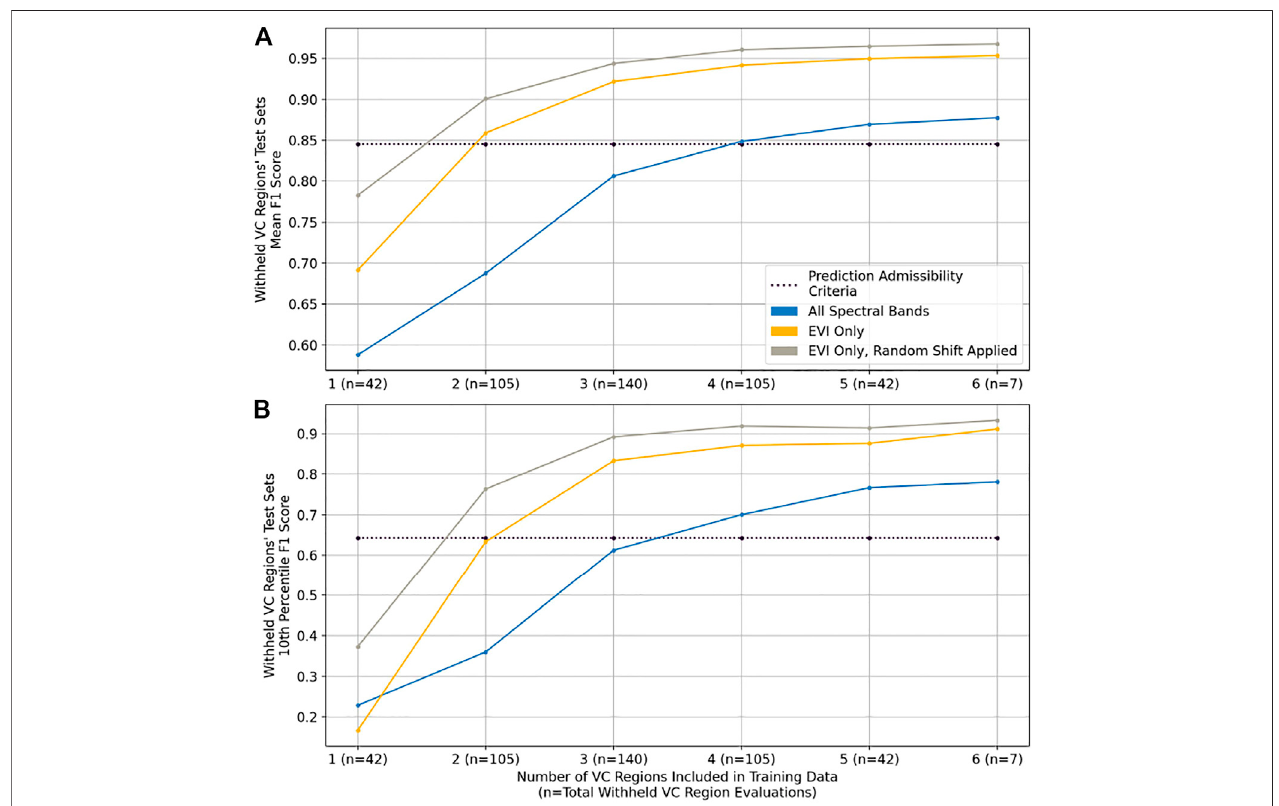
FIGURE 5 | Withheld region test dataset performance for different types of model input, organized along the x -axis by the number of regions included during training. (A) presents mean F 1 score over the withheld regions; (B) presents the 10th percentile F 1 score over the withheld regions. Results indicate that model inputs of randomly shifted enhanced vegetation index (EVI) timeseries yield the best classi fi er performance. F 1 scores from classi fi cation based on the prediction admissibility criteria are presented for reference.